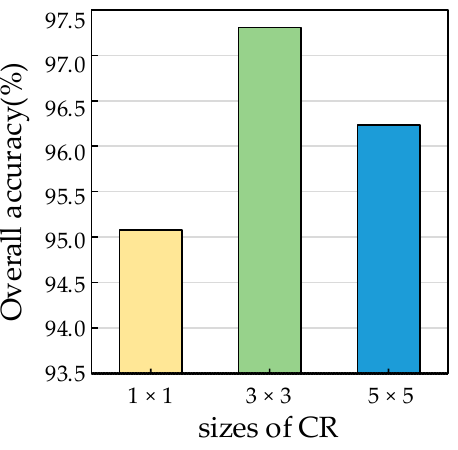
Figure 7. Overall classification accuracy for different CR sizes.